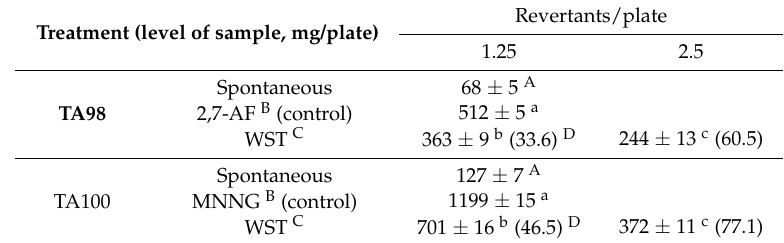
Table 3. Effect of WST extracts on the mutagenicity induced by 2, 7-AF (0.8ug/plate) in the Salmonella typhimurium TA98 strain, and induced by MNNG (0.4ug/plate) in the Salmonella typhimurium TA100